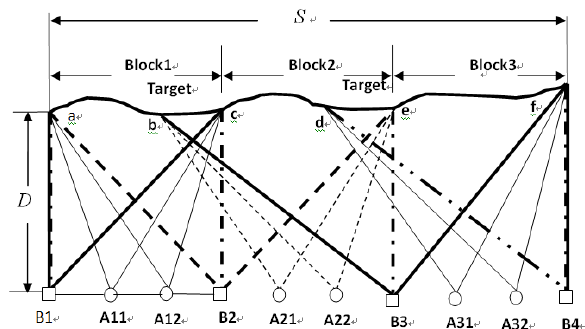
Figure2. The distribution of stations and the photograph range of each station.